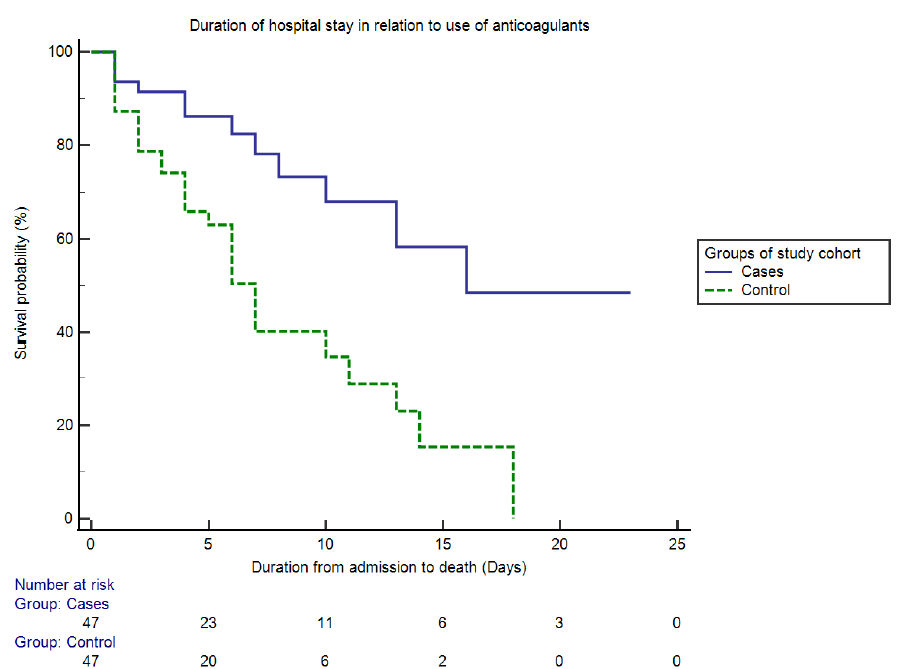
Figure 2. Kaplan–Meier curve showing the overall survival probability from hospital admission to death among two groups of the study cohort (cases vs. controls) in relation to the use of anticoagulants. The Kaplan–Meier analysis revealed that the 30-day HDU mortality for the case group was only 25.5%, compared with 61.7% for the control group ( p < 0.05). An average time spent in the hospital was 16 days for the case group and 7 days for the control group ( p < 0.05).